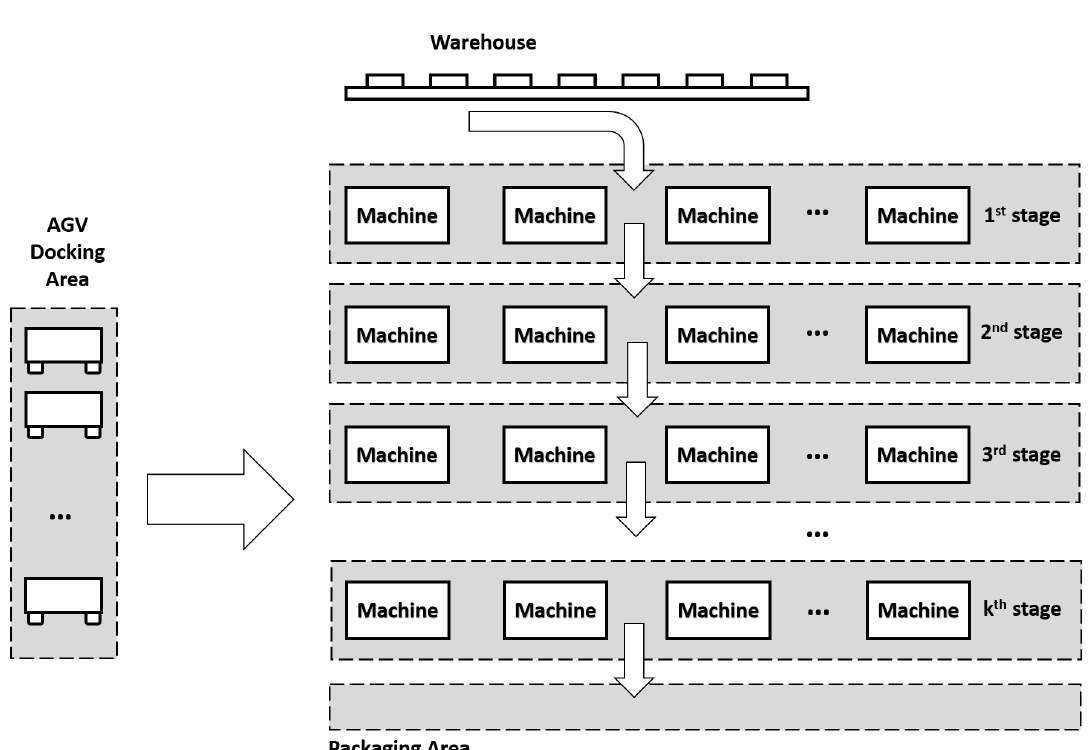
Figure 4. A schematic for the IML shop-floor logistics